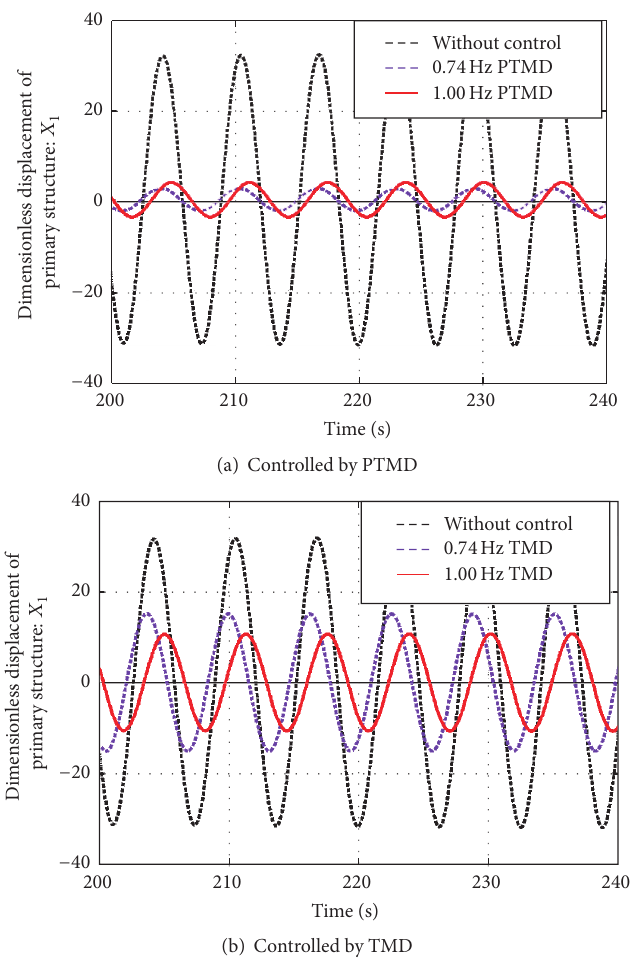
Figure 9: Control performance of TMD and PTMD in tuned excitation